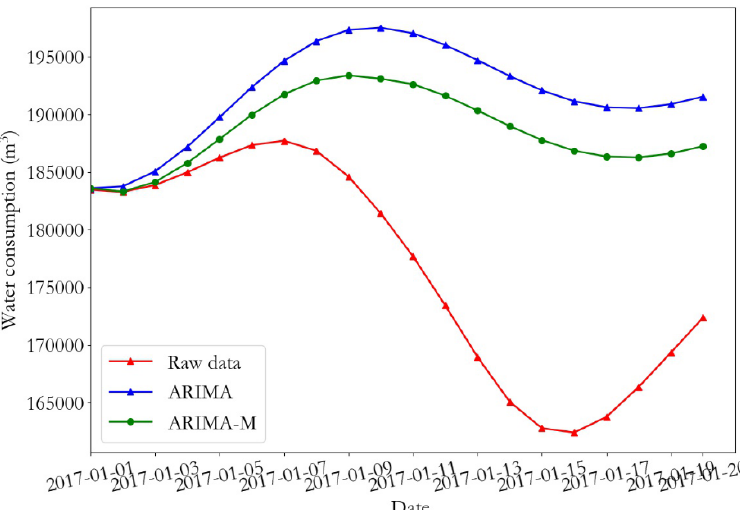
Figure 16. Prediction results of total water consumption at monitoring point 2.